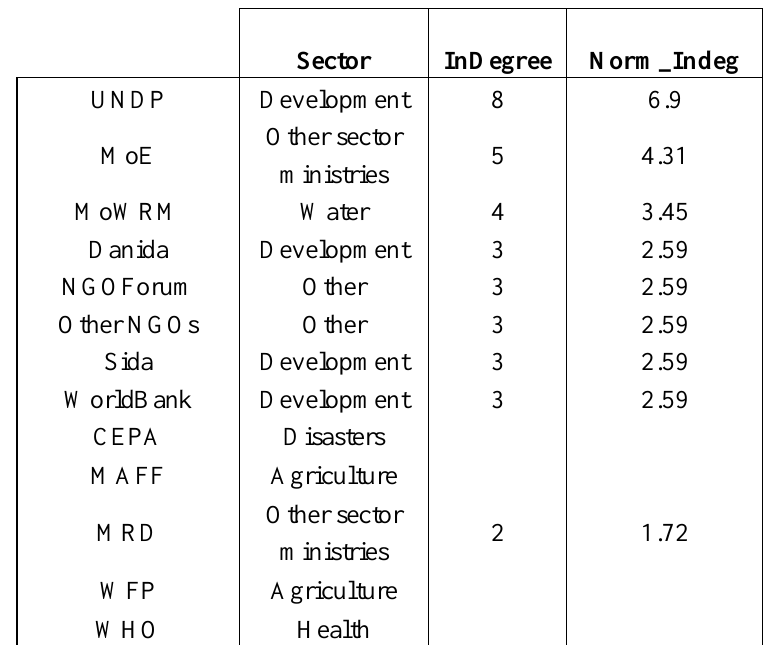
Table 9. Informal partnerships with organisations working in climate change adaptation: Most prominent/central